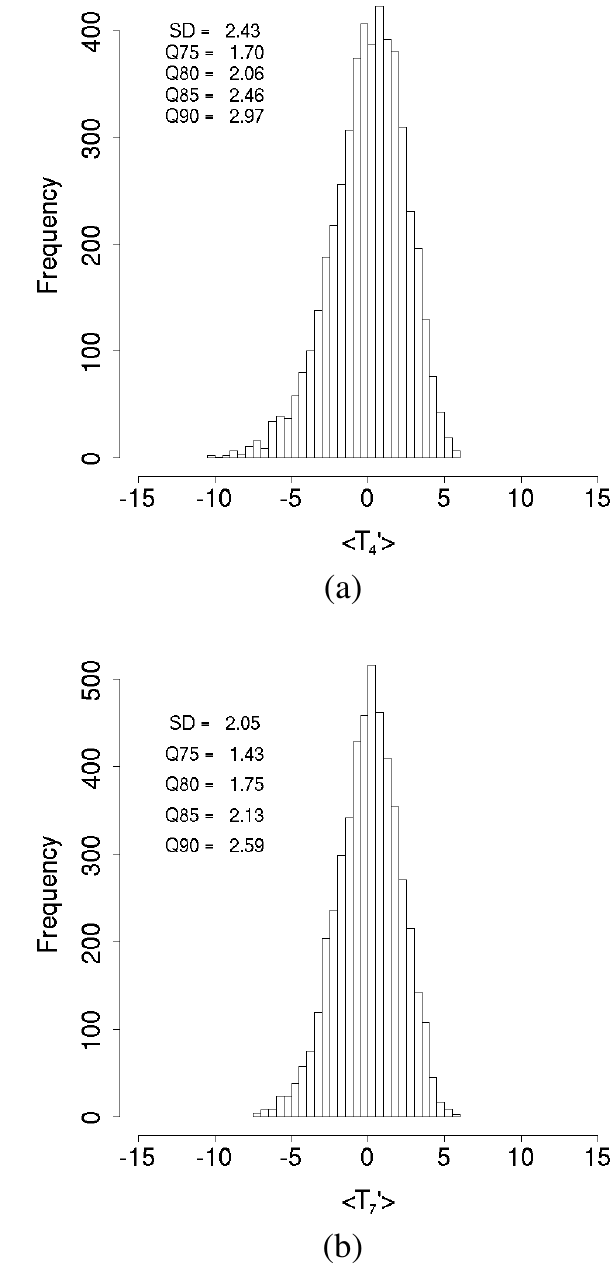
Fig. 2. Frequency distributions of the mean temperature anomalies Fig. 2 – Frequency distributions of the mean temperature anomalies over the target area (a) over the target area (a) 4-day averaged anomaly and (b) weekly 4-day averaged anomaly and (b) weekly averaged anomaly. SD is standard deviation. Q75, averaged anomaly. SD is standard deviation. Q75, Q80, Q85, Q90 Q80, Q90 are the percentile values at 75%, 80%, 85%, and 90% level. ( ° C). are the percentile values at 75%, 80%, 85%, and 90% level. ( ◦ C).